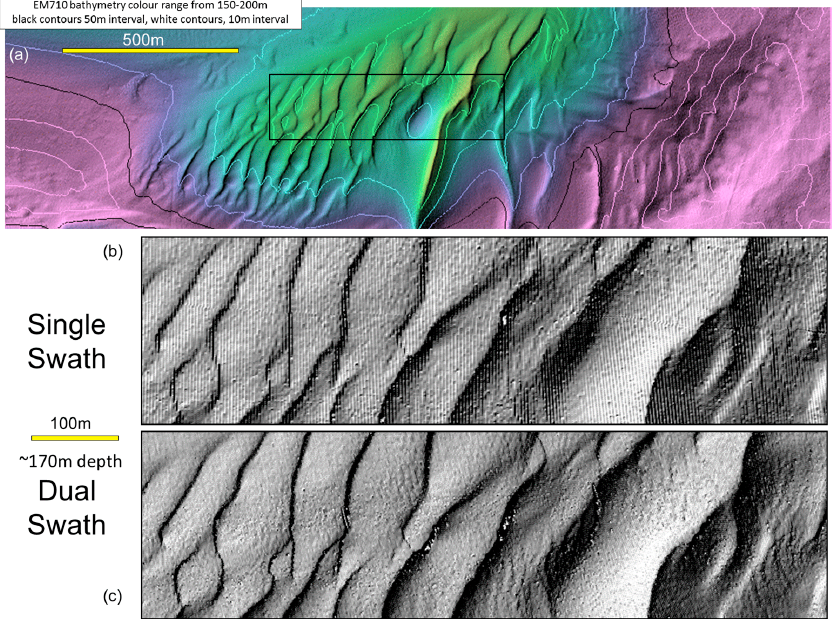
Figure 10. Impact of multi-swath. Two successive passes of the same multibeam system (EM710 0.5° × 1.0°) over a field of multi-scale dunes in 170 m of water. Speeds from 7–9 knots, both passes using a ±65° sector. ( a ) Regional location; ( b ) resolved relief using single swath mode; ( c ) resolved relief using dual swath mode.